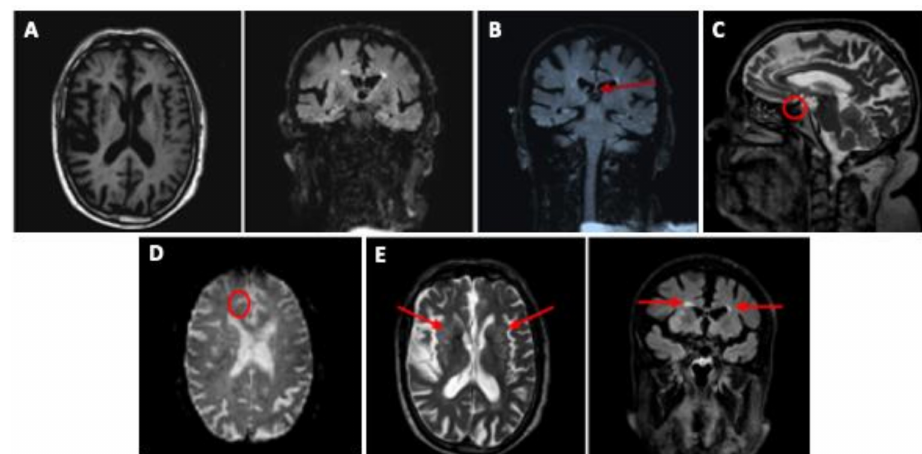
Figure 1. Brain MRI of the boxer. A. Axial T1 (left) and coronal flair (right) sections showing significant fronto-temporal- parietal cortical and sub-cortical atrophy with ventricular dilatation, and mild hippocampal atrophy bilaterally. B. Coronal flair section showing slight cavum septum pellucidum. C. Sagittal T2 section showing slightly atrophic pituitary gland. D. Axial proton density weighing (DP) section showing diffuse axonal injury. E. Axial T2 (left) and coronal flair (right): numerous vascular lacunae in the basal ganglia bilaterally (cribrate aspect) and per-ventricular